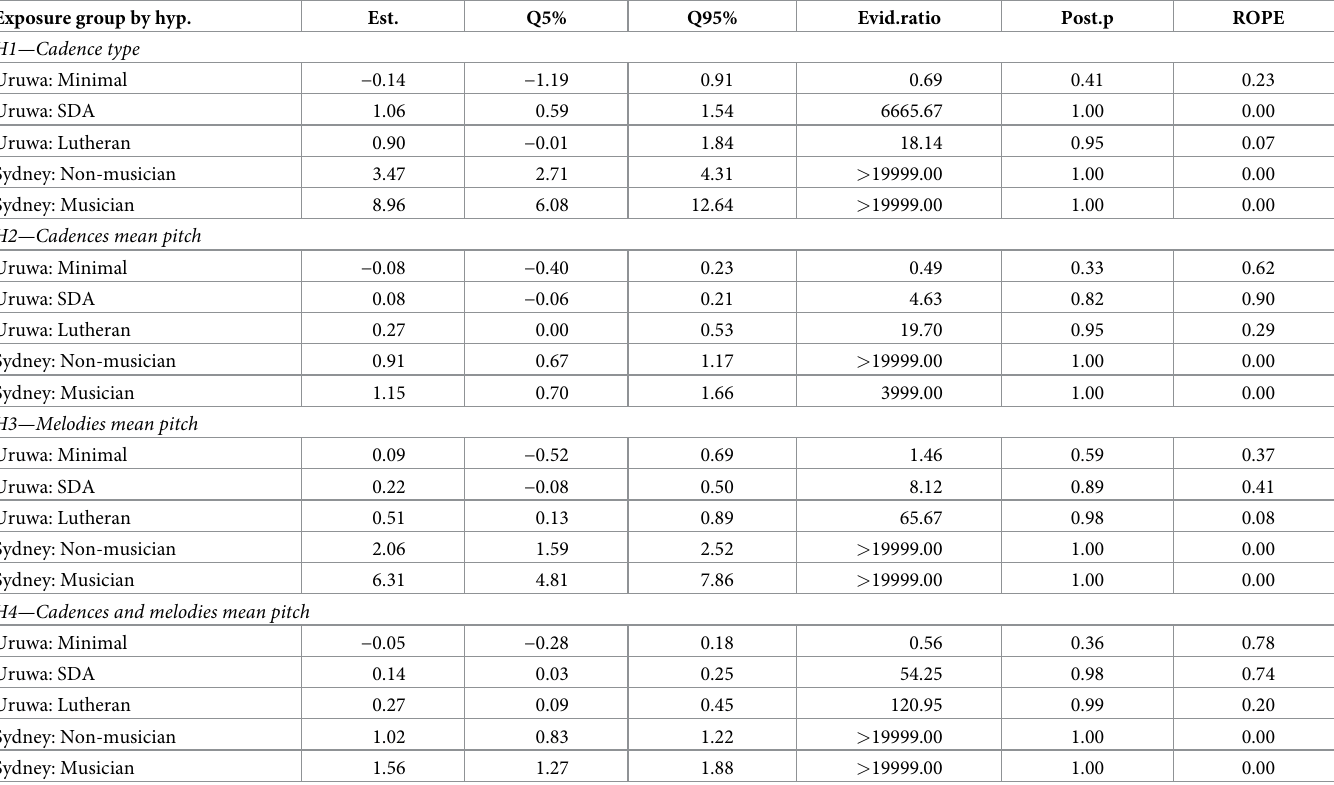
Table 1. Hypothesis tests and summaries of the models’ principal effects across the five groups of participants (the hypotheses are detailed in the main text). ‘Est’, ‘Q5%’, and ‘Q95%’ show the mean and 90% equal-tailed credibility interval for the effect of Min to Maj compared to Maj to Min (H1) or a one-semitone increase in mean pitch (H2–H4). This effect is expressed on the logit (log-odds) scale. ‘Evid.ratio’ is the odds that the effect is in the direction specified by the hypothesis, and ‘Post.p’ is the associated posterior probability of the hypothesis ( Evid.ratio = Post.p /(1 − Post.p )). We consider evidence ratios > 10 to be strong evidence; > 30 to be very strong. ‘ROPE’ shows the probability that the effect is small enough to be practically equivalent to zero [27], which we define as being in the interval [ − 0.18, 0.18]. Exposure group by